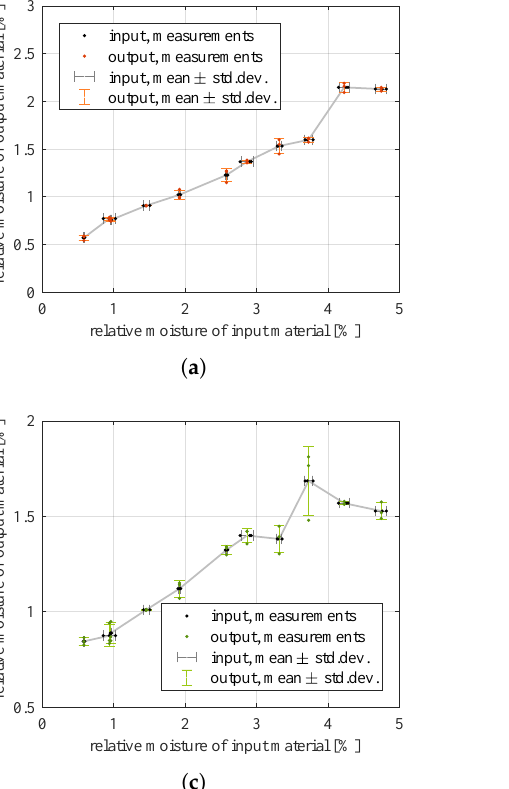
Table 2. Coefficients and statistical parameters of fitted straight lines between moisture of clas- sification products and moisture of input material. low —lower product, up —upper product, 50% and 100%—percentage of nominal throughput of the screw feeder, SD–standard deviation, WMSE—weighted mean squared error (2), R 2 —coefficient of determination (A5), R 2 coefficient of determination